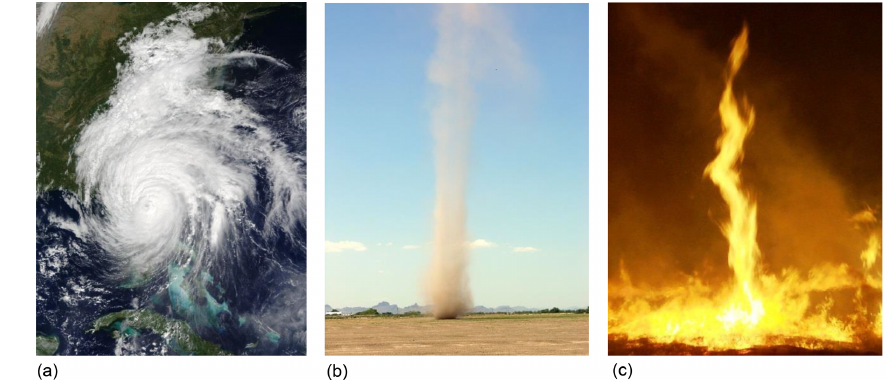
Figure 1. (a) A visible image of Major Hurricane Matthew taken from NASA’s Terra satellite on 7 October 2017 at 00:00EDT as it continued moving along Florida’s East Coast. Matthew was a Category 3 hurricane at the time of this image (Credit: NASA’s Goddard MODIS Rapid Response Team). (b) A dust devil in Arizona (source: Wikipedia, credit: NASA). (c) A fire whirl at 19 February 2002 (source: Wikipedia, credit: the US Fish and Wildlife